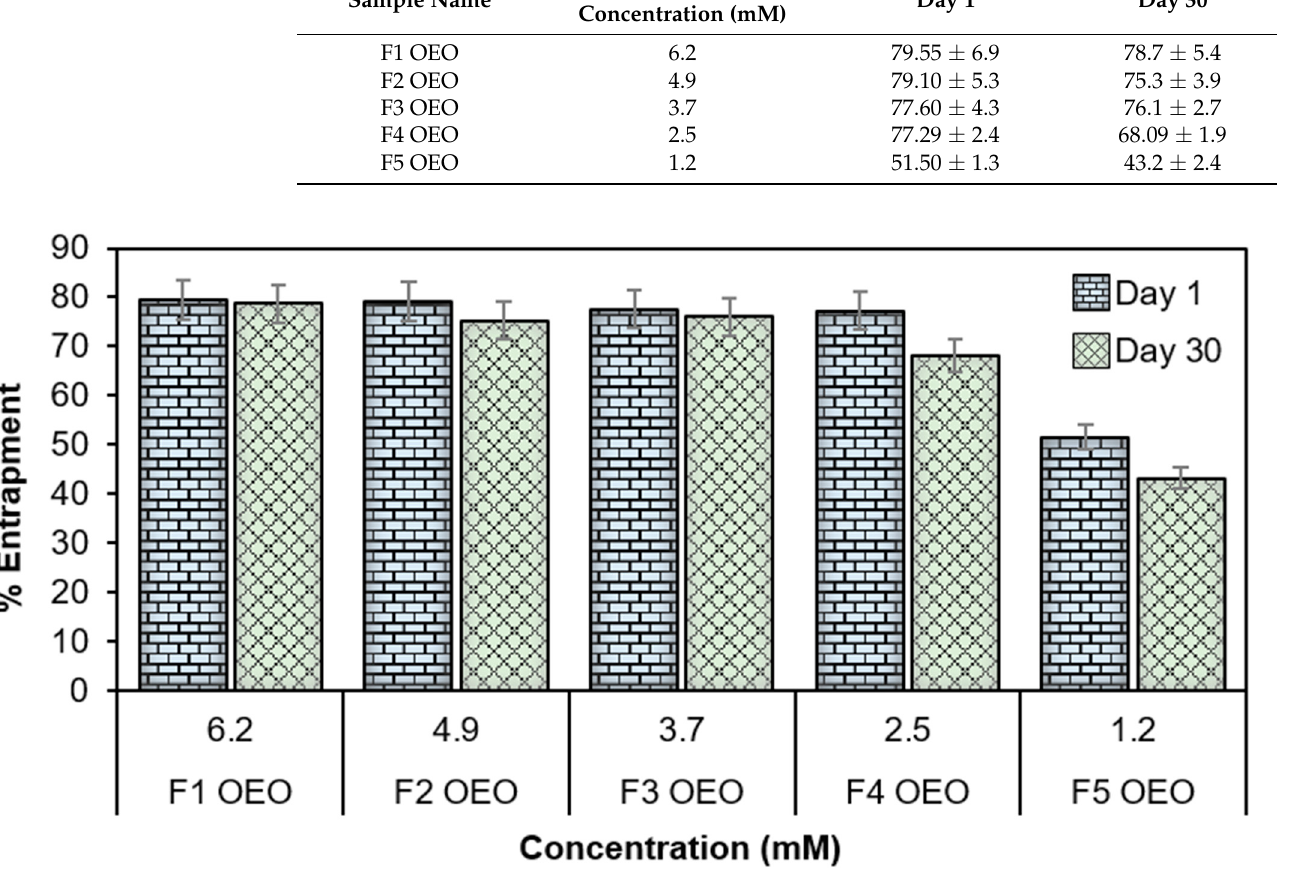
Figure 6. Entrapment efficiency percentage (%EE) of OEO nanoliposomes 1 day and 30 days after preparation.